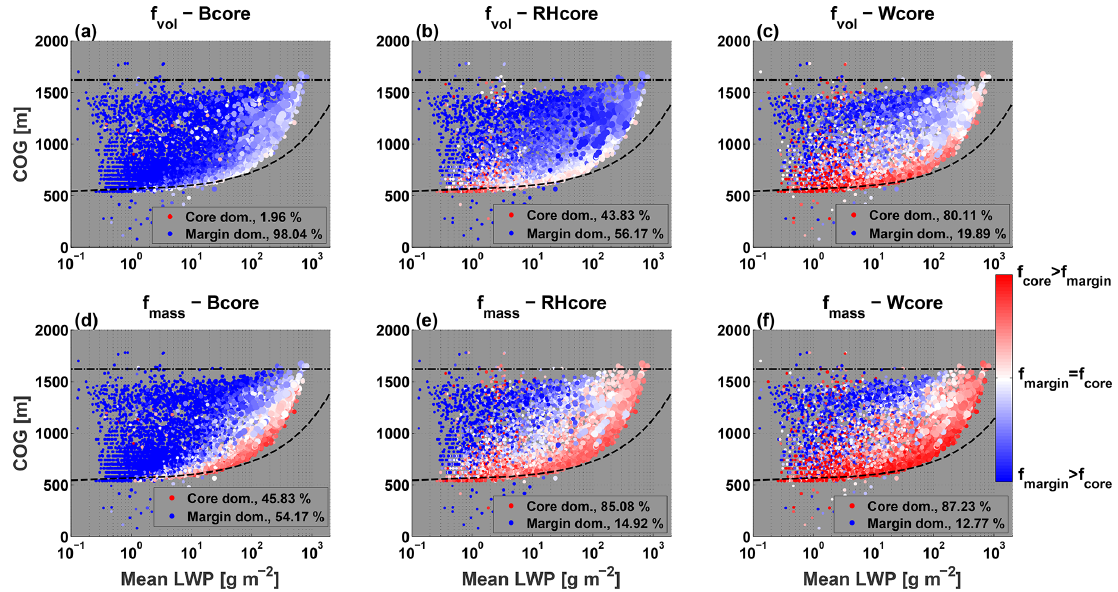
Figure 4. CvM phase-space diagrams of B core (a, d) , RH core (b, e) , and W core (c, f) fractions for all clouds between 3 and 8h in the BOMEX simulation. Both volume fractions ( f vol ; a, b, c ) and mass fractions ( f mass ; d, e, f ) are shown. The red (blue) colors indicate a core fraction above (below) 0.5. The size of each point in the scatter is proportional to the cloud mean area, where the smallest (largest) point corresponds to an area of 0.01 (2.36)km 2 . The percentage of clouds that are core dominated ( f vol f mass > 0 . 5) is included in panel legends. For a general description of CvM space characteristics, the reader is referred to Sect.